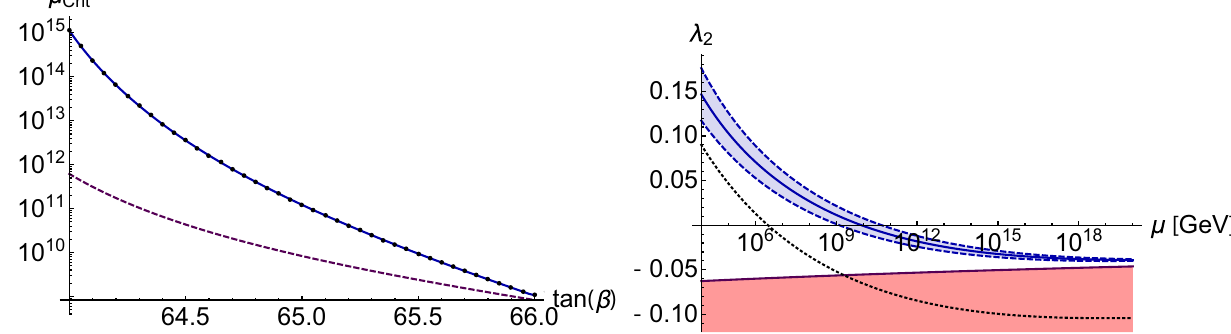
Fig. 5 Left: scale μ crit at which the quartic coupling λ 2 (μ) turns neg- ative as a function of tan β . The two-loop RG improved λ 2 l as a blue line, the one-loop result as comparison is shown dashed in purple. Right: RG flow of the full quartic coupling λ ef f